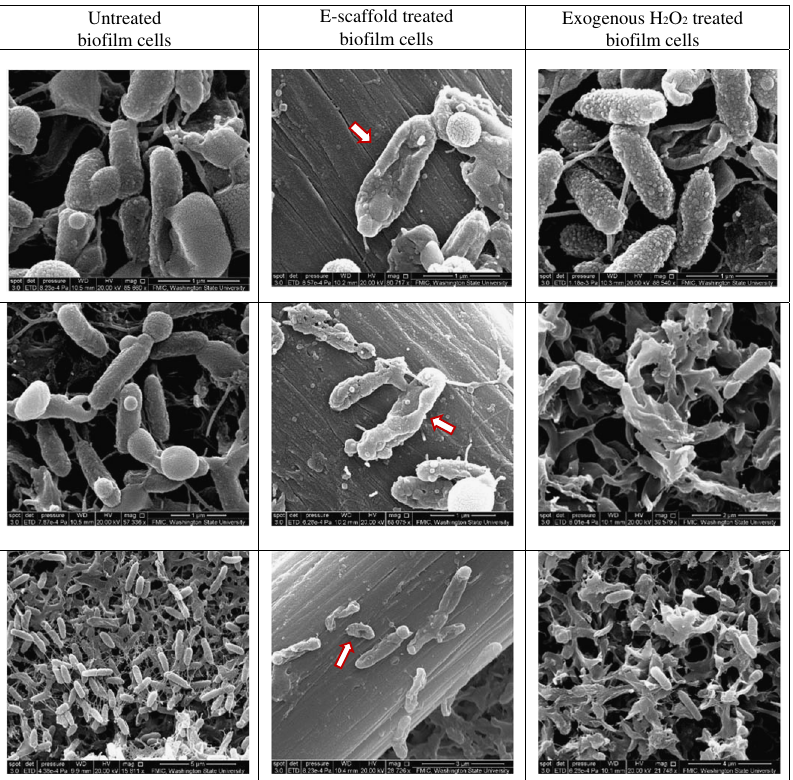
Fig. 4 Scanning electron microscopy (SEM) images showing untreated, e-scaffold treated and exogenous H 2 O 2 treated P. aeruginosa PAO1 bio fi lm cells. Three representative images are shown for each treatment. Red arrows indicate cells showing a stressed